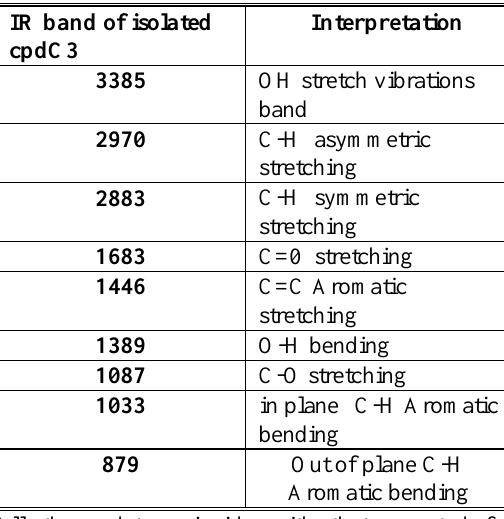
Table 7.interpretation of the IR bands for C3 were shown